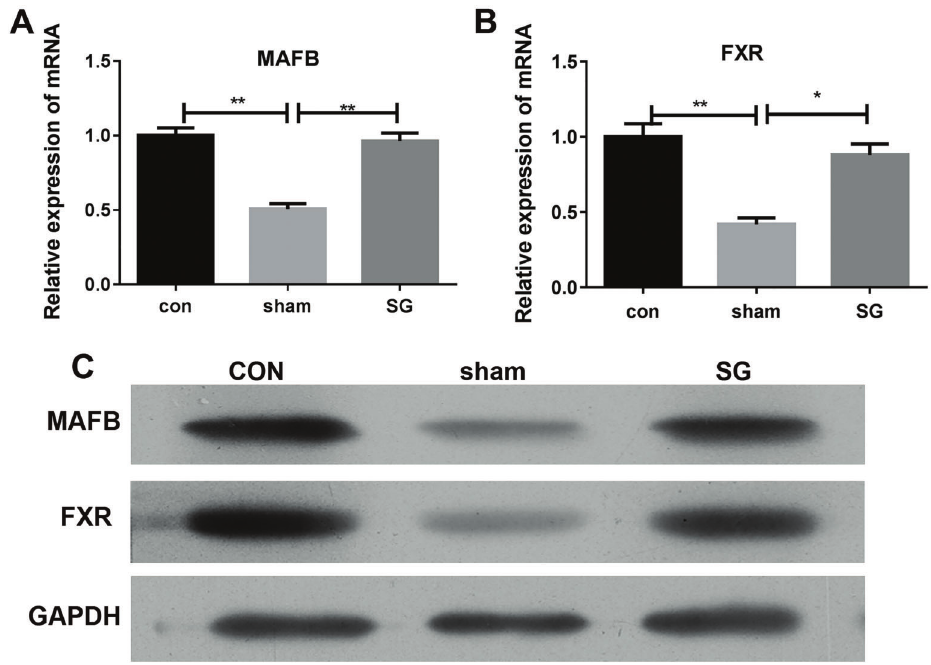
Figure 3. A , MAFB and B , FXR mRNA levels in sleeve gastrectomy (SG), sham, and control (CON) rats measured by quantitative RT-PCR. C : MAFB and FXR protein levels determined by western blotting. GAPDH was applied as the internal control. MAFB: